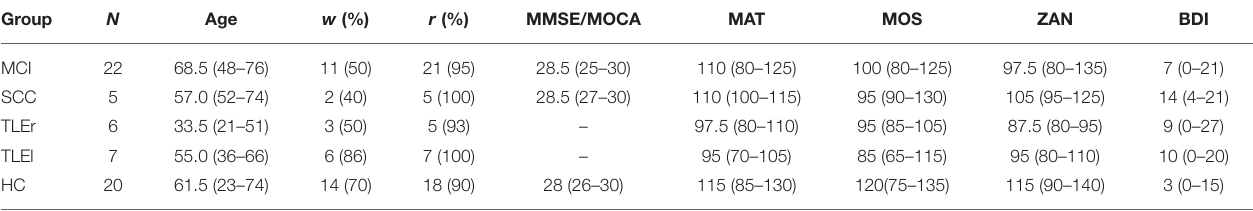
TABLE 1 | Sample overview.